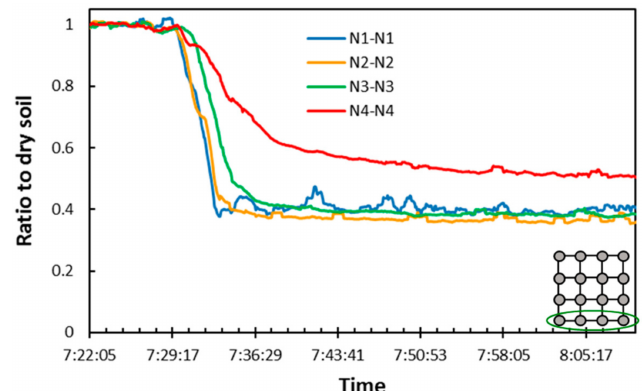
Figure 9. Relative resistance measured between pairs of electrodes at the bottom of the soil sample (electrode pairs #1–#4.), shown as a function of time. Water accumulated at the bottom of the soil sample, resulting in a rapid decrease of resistance for several electrode